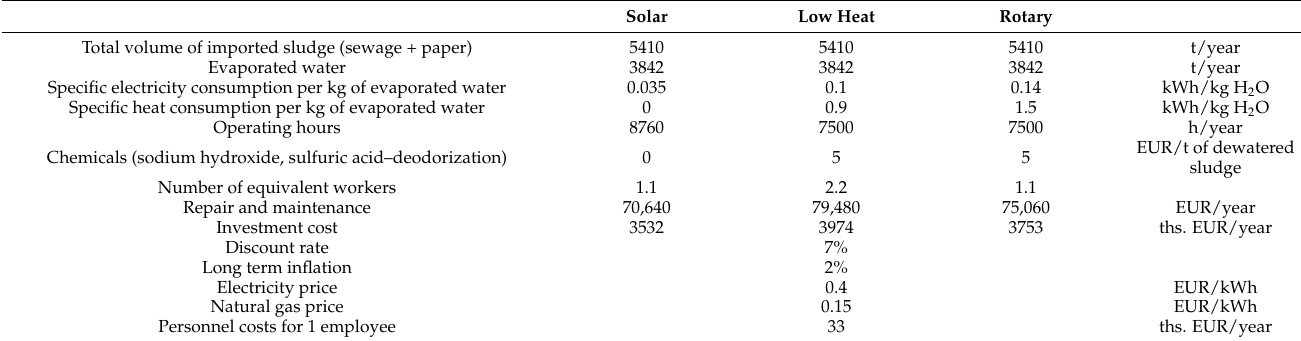
Table 2. Calculation inputs.